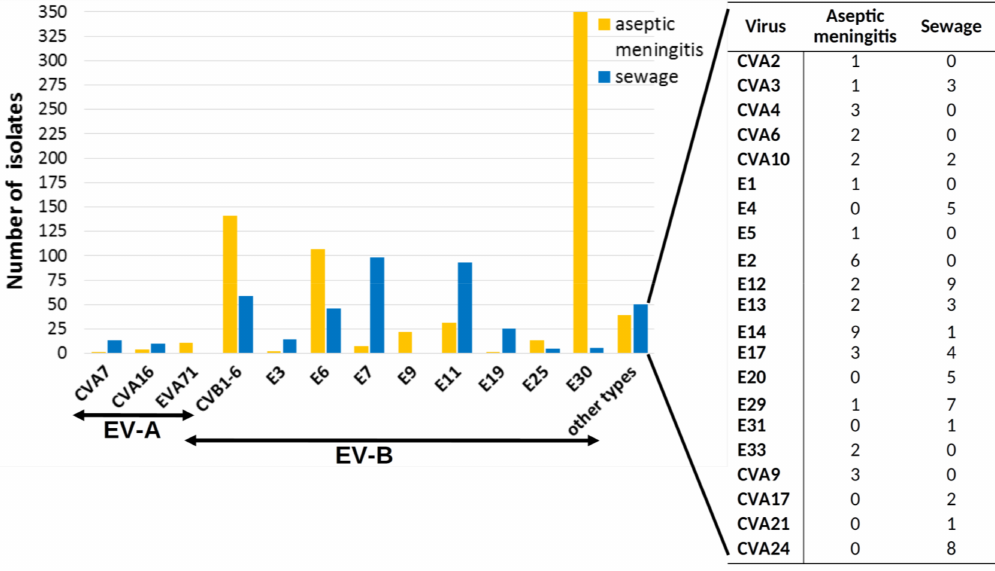
Figure 5. Spectrum of NPEV isolated from sewage and from cases of aseptic meningitis, Moscow, 2008–2017.